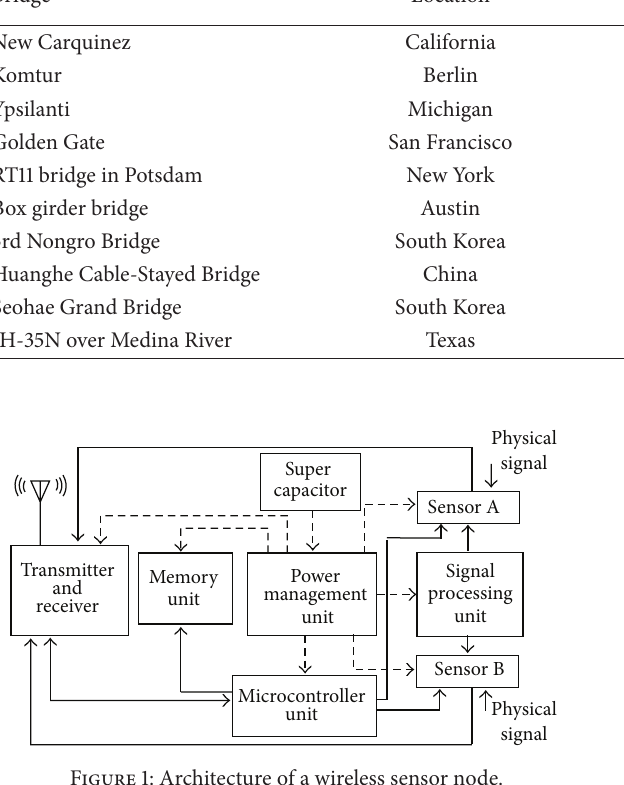
Figure 1: Architecture of a wireless sensor